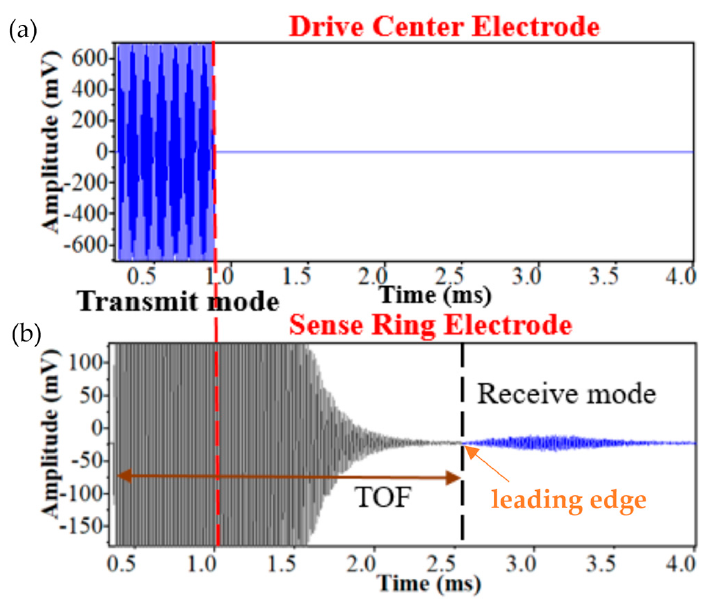
Figure 3. Illustration of the threshold TOF method. ( a ) The transmitting signals. ( b ) The receiving signal. Reproduced with permission from [39] , Copyright 2019, IEEE.